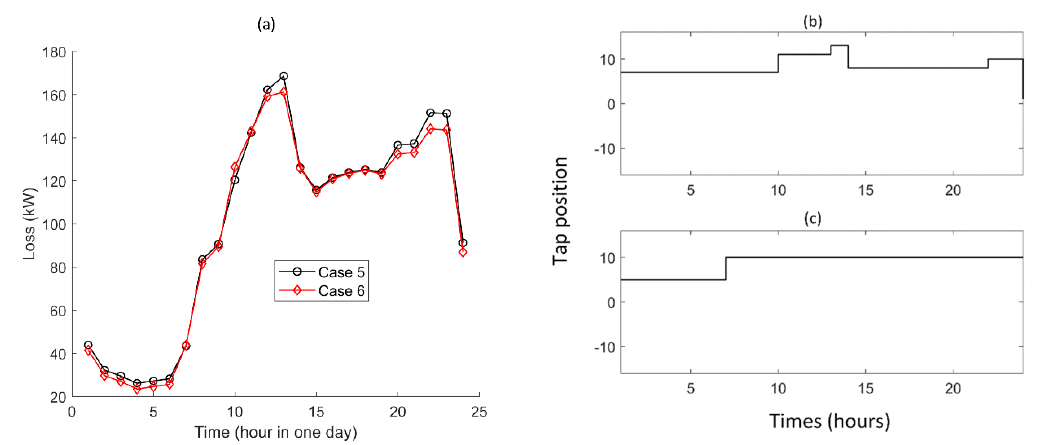
Figure 9. Comparisons of network losses ( a ) and tap position changes of one voltage regulator by cases 5 ( b ) and case 6 ( c ).